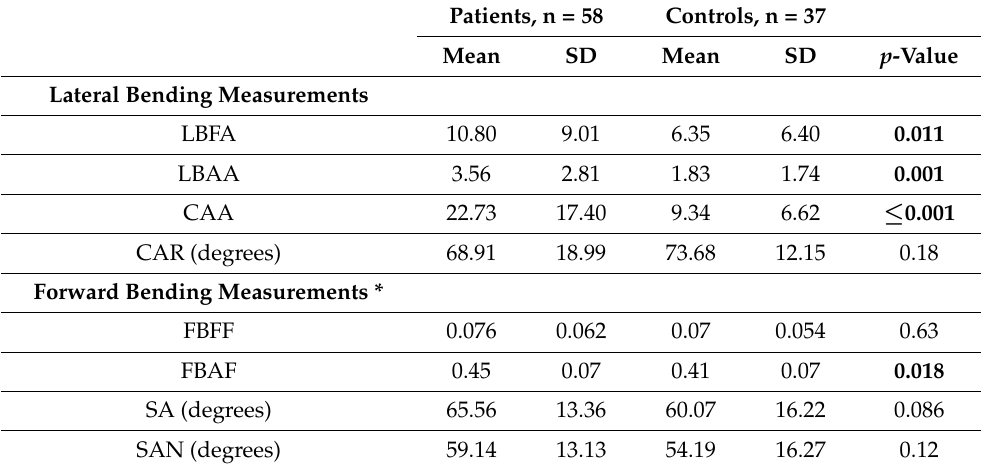
Table 5. Comparison of AIS patients to